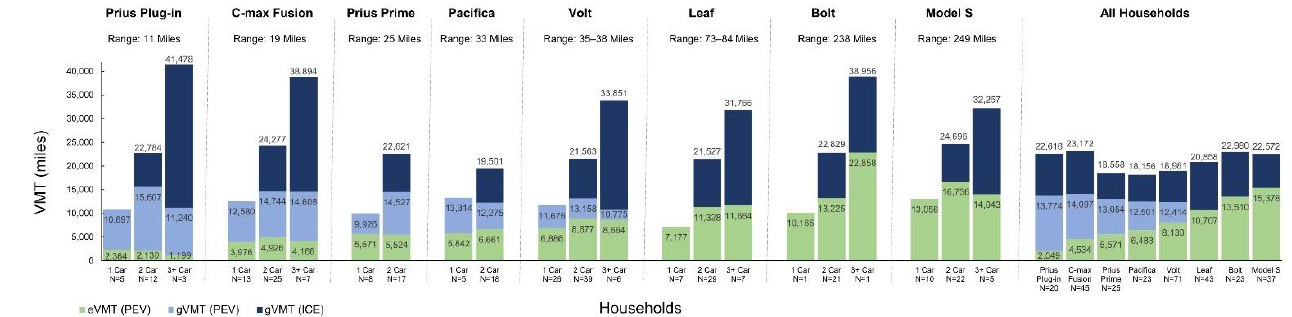
Figure 2. VMT of households, categorized by PEV-type and total number of cars in the household.